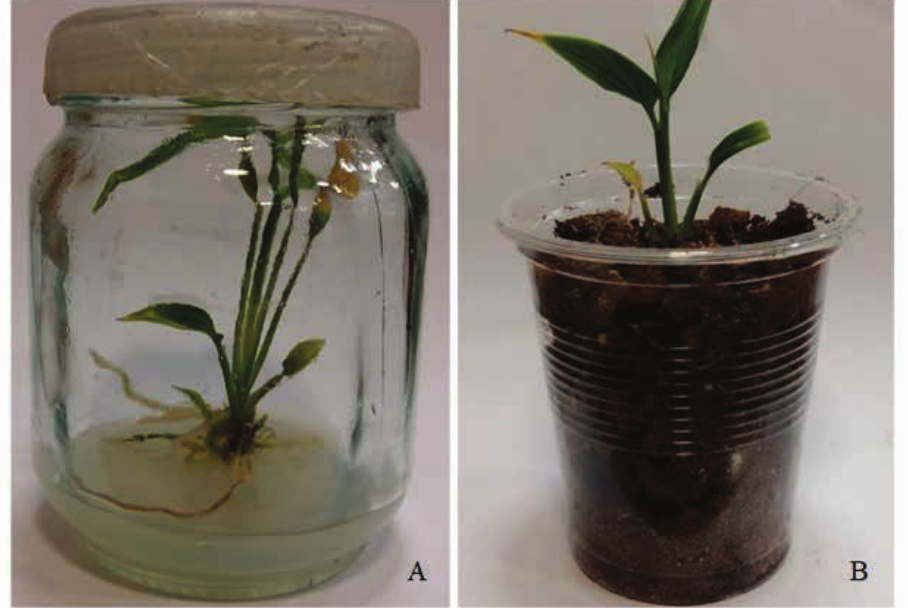
Figure 5: Rooting response of ginger cultured on MS medium containing 2 mg/l IBA four weeks after cultivation (A). Acclimatization of micro- propagated ginger plantlet four weeks after transferring